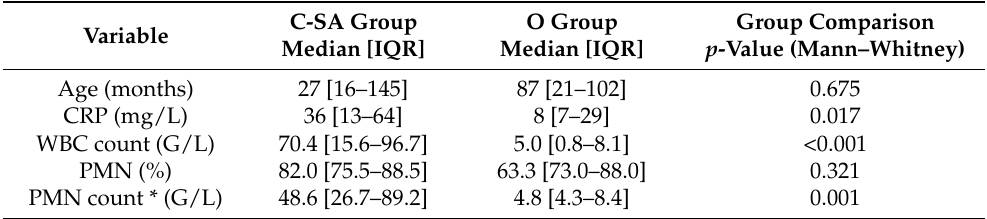
Table 1. Sample characteristics (median and inter-quartile range (IQR)) in confirmed septic arthritis (C-SA) and other (O) groups, with statistical significance of between-group differences assessed using the p -value of a Mann–Whitney test. C—reactive protein CRP, white blood counts WBC count, polymorphonuclear cells PMN (%) and PMN count are from synovial fluid.